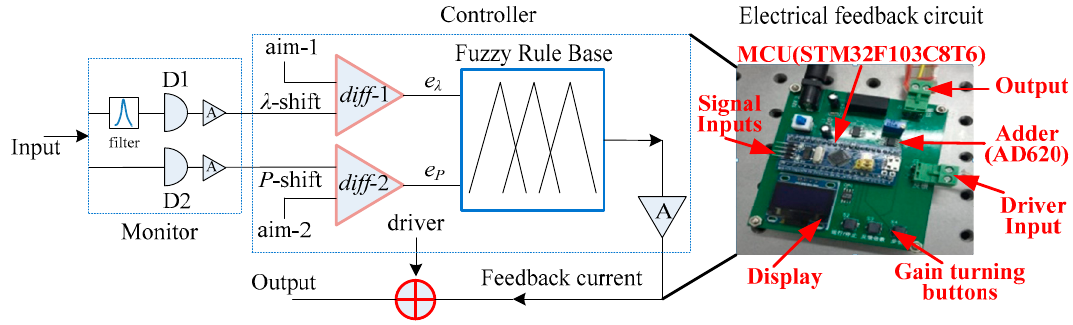
Figure 3. Scheme of dual-channel fuzzy controller, D1/D2: detector, A: amplifier, diff -1/ diff -2: differential amplifiers, MCU: microcontroller unit.